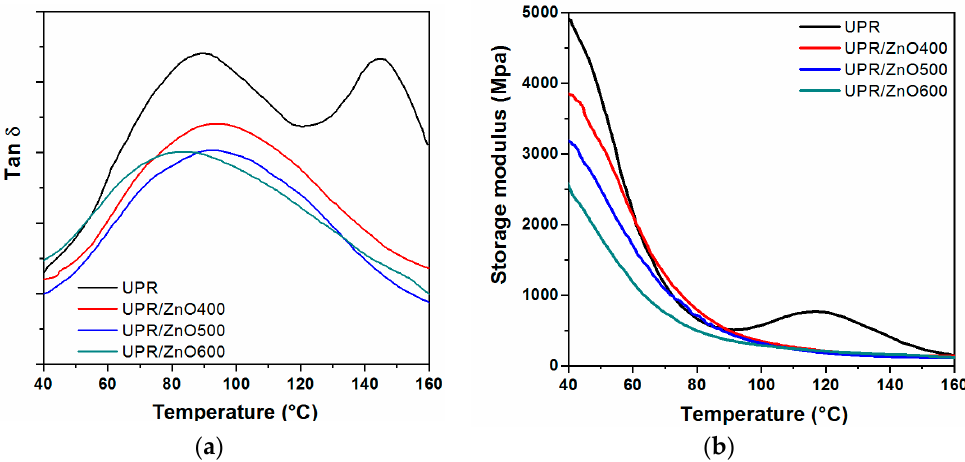
Figure 3. DMA curves from UPR and nanocomposites: ( a ) storage modulus and ( b ) tan δ .